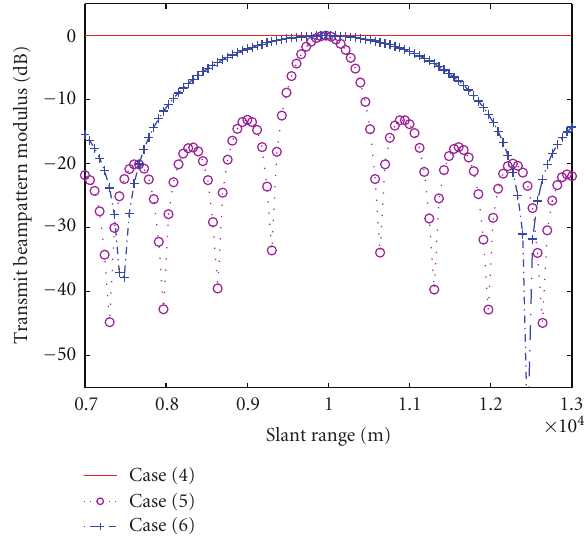
Figure 5: The comparative transmit beampatterns in range dimen- sion when Δ f / =